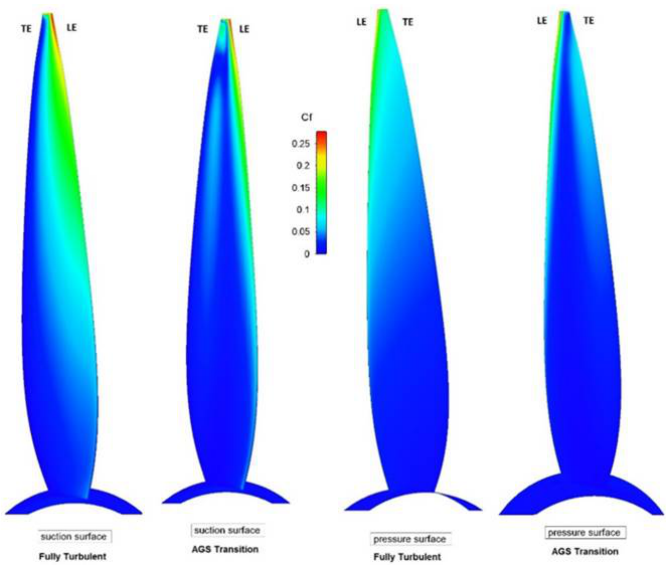
Figure 27. Skin friction for fully turbulent and transition model activated on suction and pressure surfaces for same domain size.